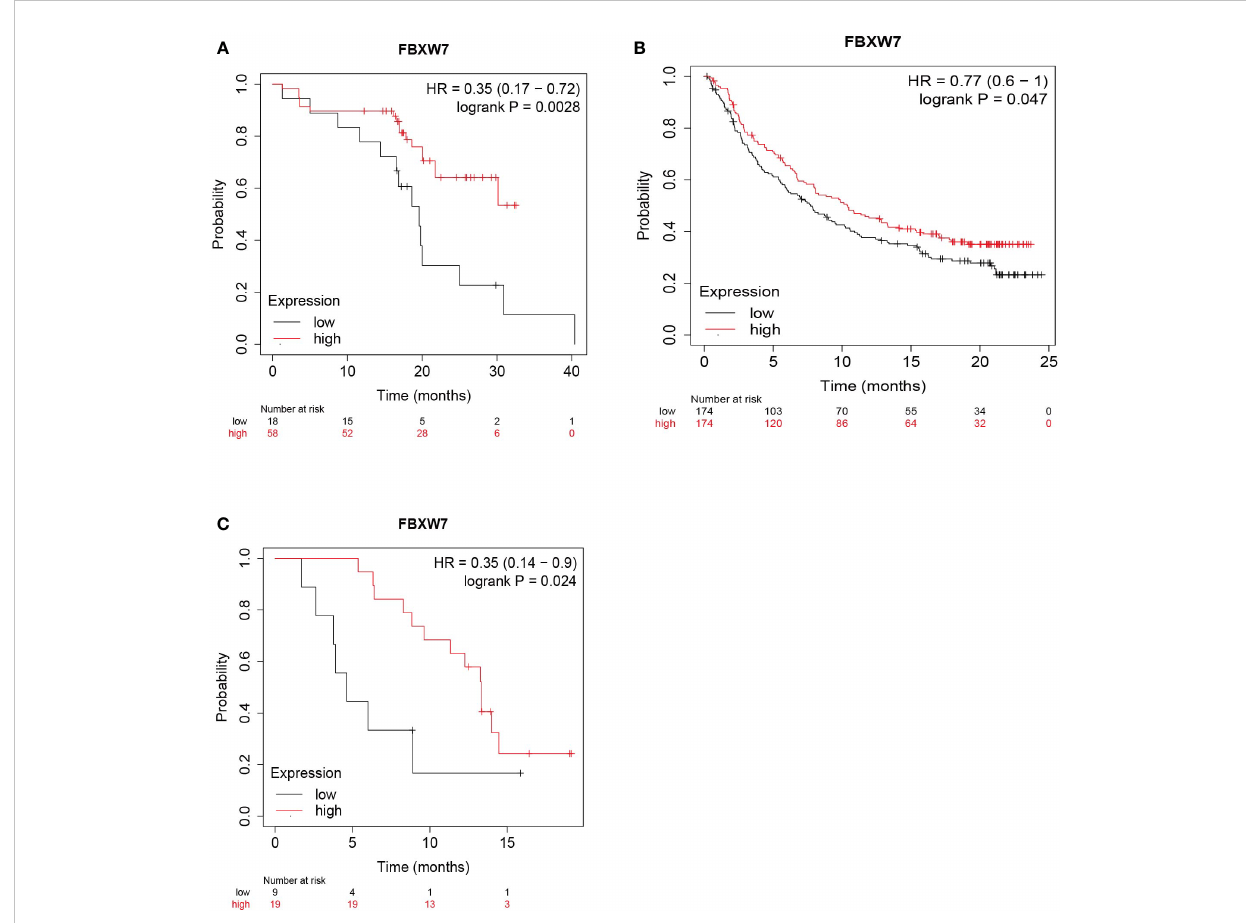
FIGURE 4 The survival rate of patients with high and low expression is performed using Kaplan Meier plotter. (https://kmplot.com/analysis/index.php?p=service) (A) Esophageal adenocarcinoma patients who accept all anti-PD-L1 treatment shows that people with high levels of FBXW7 owns a longer survival time. (B) Urothelial carcinoma patients who accept all anti-PD-L1 treatment shows that people with high levels of FBXW7 owns a longer survival time. (C) Glioblastoma patients who accept all anti-PD-1 treatment shows that people with high levels of FBXW7 owns a longer survival